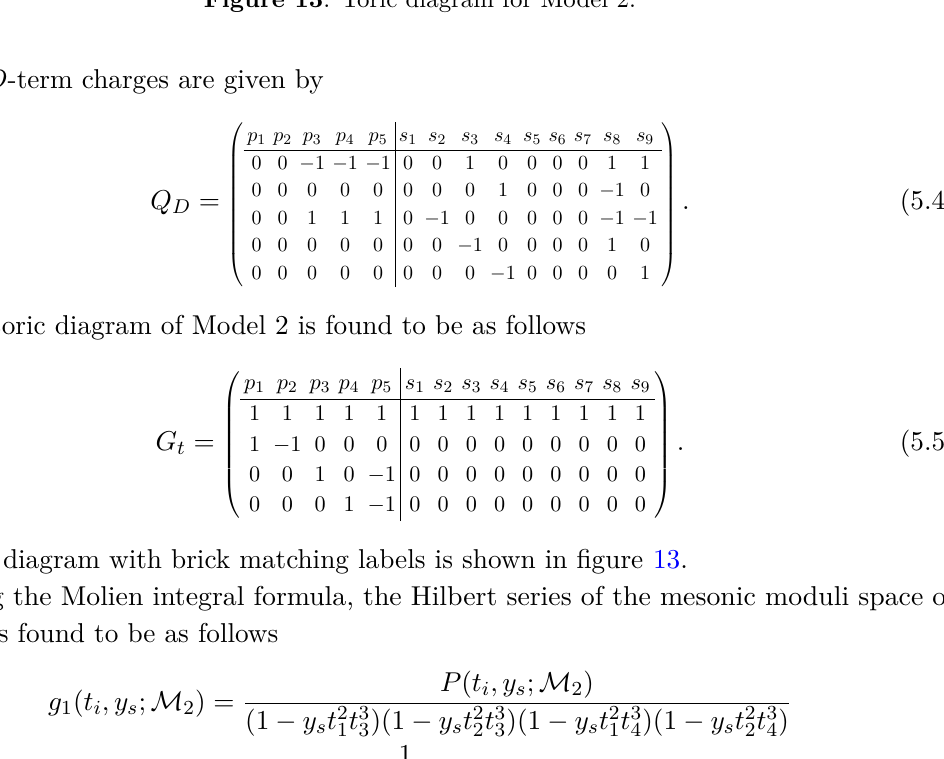
Figure 13 . Toric diagram for Model